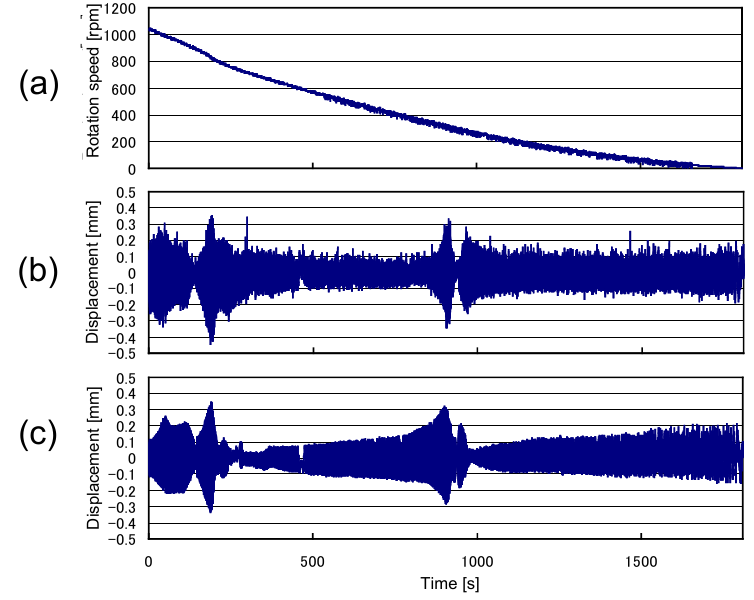
Figure 6. Free-run experimental results representing ( a ) the natural rotational decay curve, ( b ) displacement at an upper position of the rotor and ( c ) displacement at a lower position of the rotor. Figure 7 shows the free-run experimental results representing (a) displacements at the upper rotor (upper figure) and lower rotor (lower figure) at a speed of ≈ 300 rpm and (b) displacements at the upper rotor (upper figure) and lower rotor (lower figure) at a speed of ≈ 800 rpm. Both displacements, at the speeds of ≈ 300 rpm and ≈ 800 rpm, are less than 0.3 mm o-p . The displacement phase of the upper figure in Figure 7a is almost the same as the phase of the lower figure in Figure 7a. This means that the flywheel rotor spins in a cylindrical motion at a speed of ≈ 300 rpm. Additionally, the displacement phase of the upper figure in Figure 7b is almost the same as the phase of the lower figure in Figure 7b. This means that the flywheel rotor also spins in the cylindrical motion at a speed of ≈ 800 rpm.